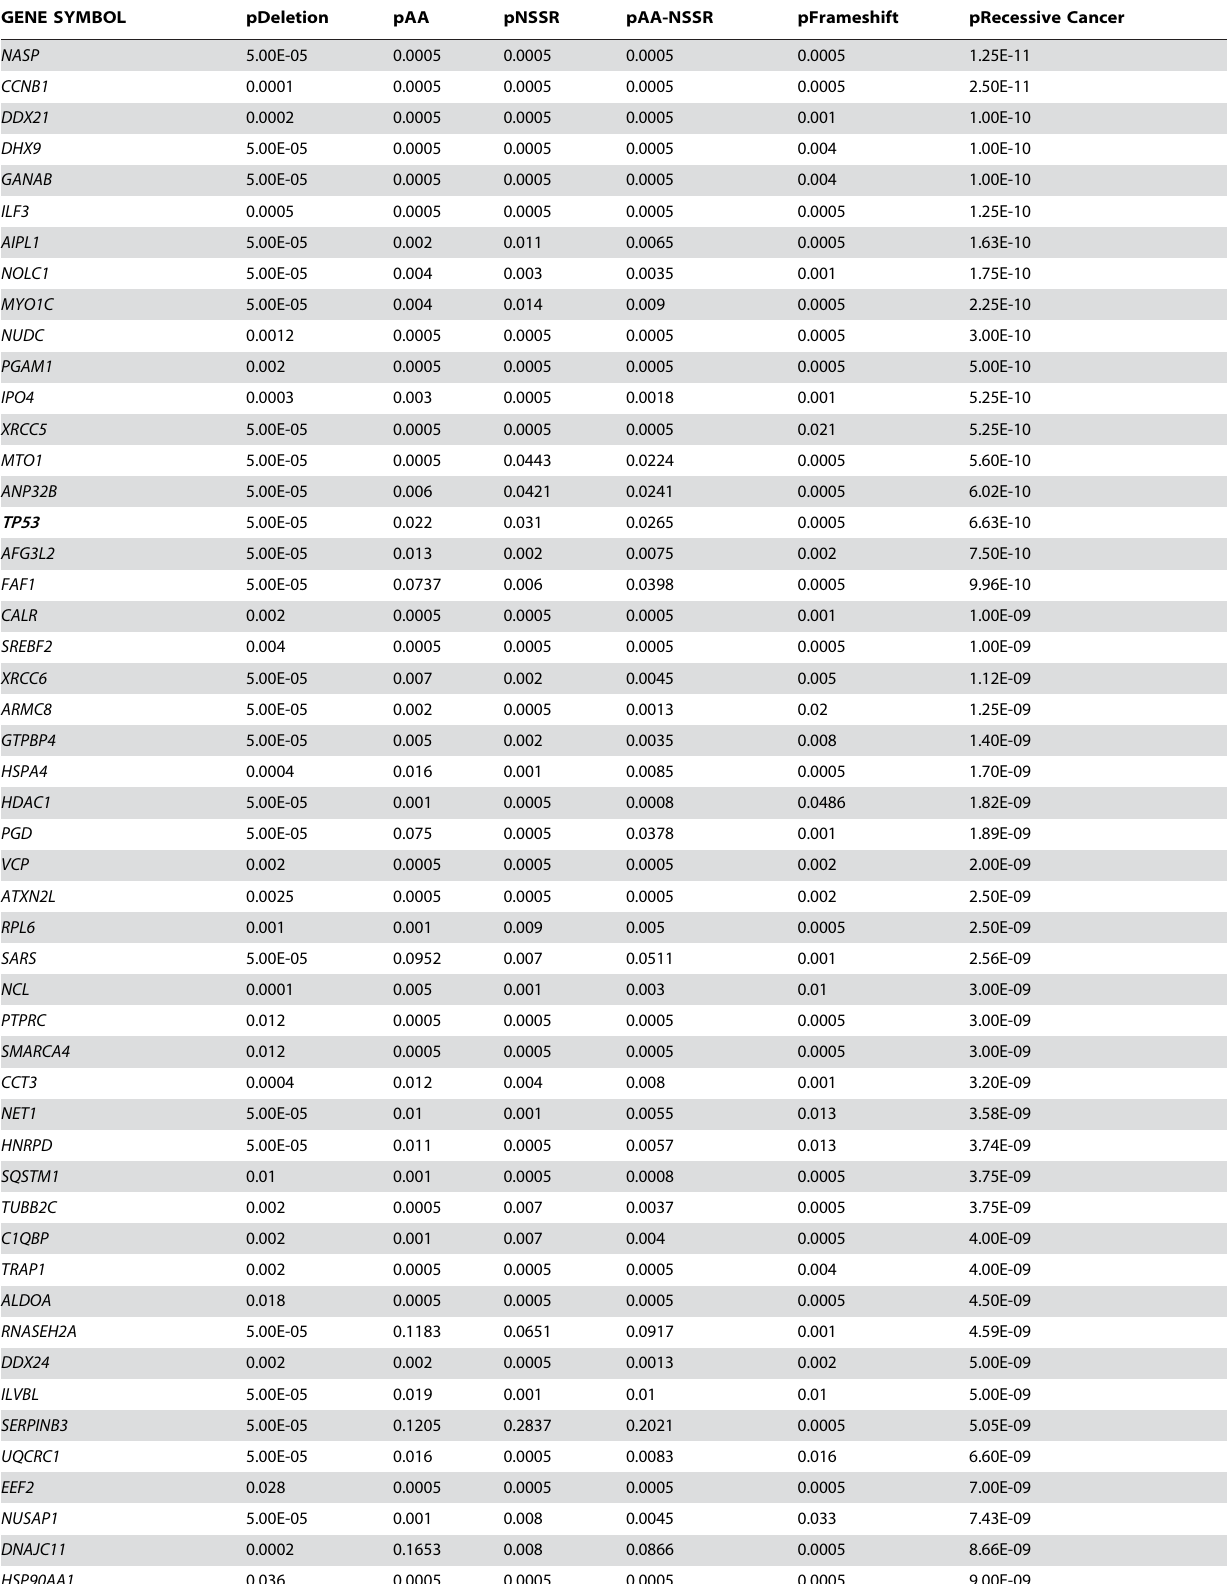
Table 1. Mutation p-values for the candidate recessive cancer